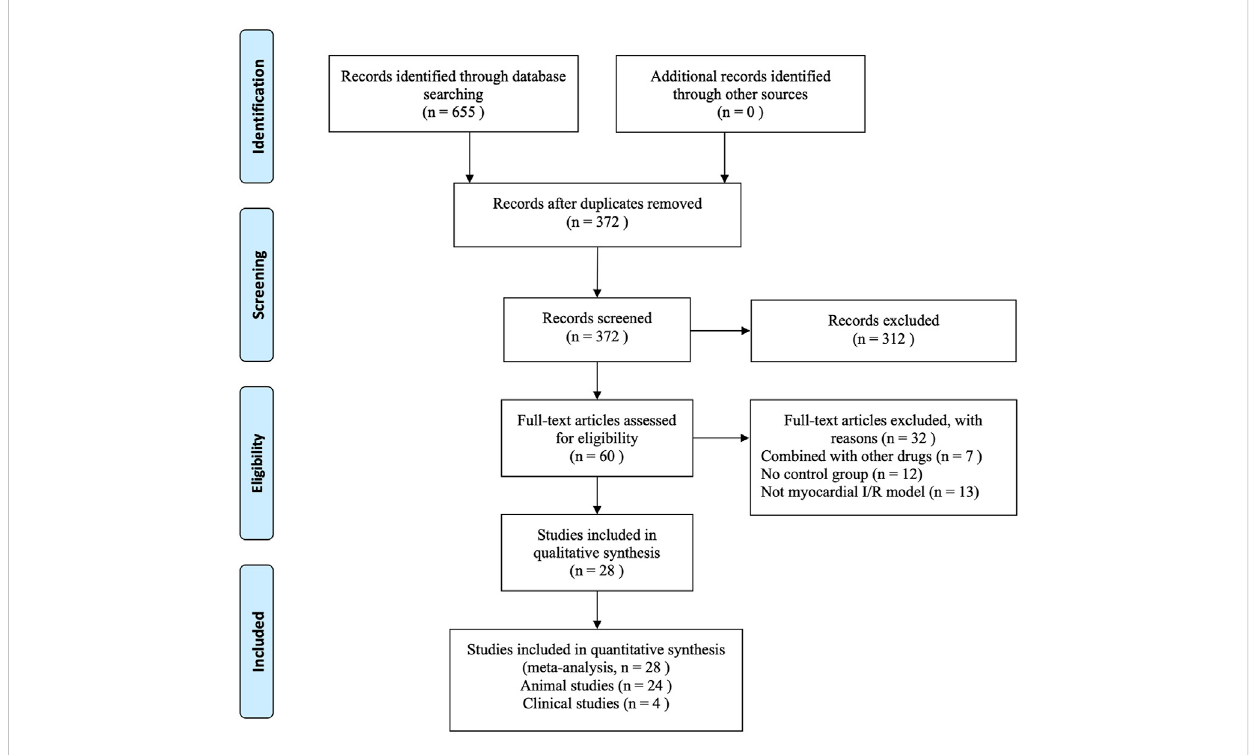
FIGURE 2 Flow chart of the process of study